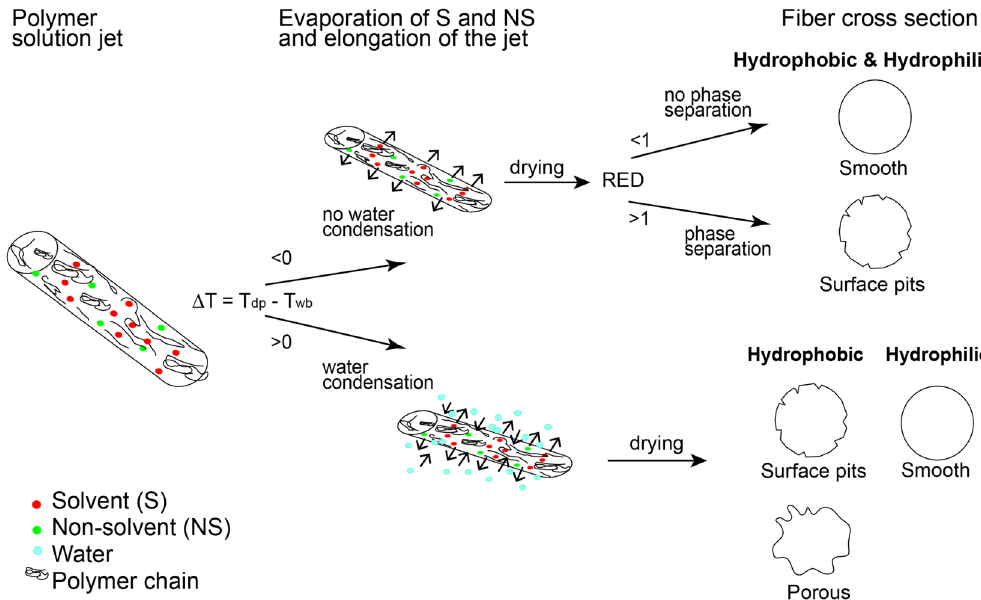
Figure 7. Depiction of pore formation mechanism for the electrospinning